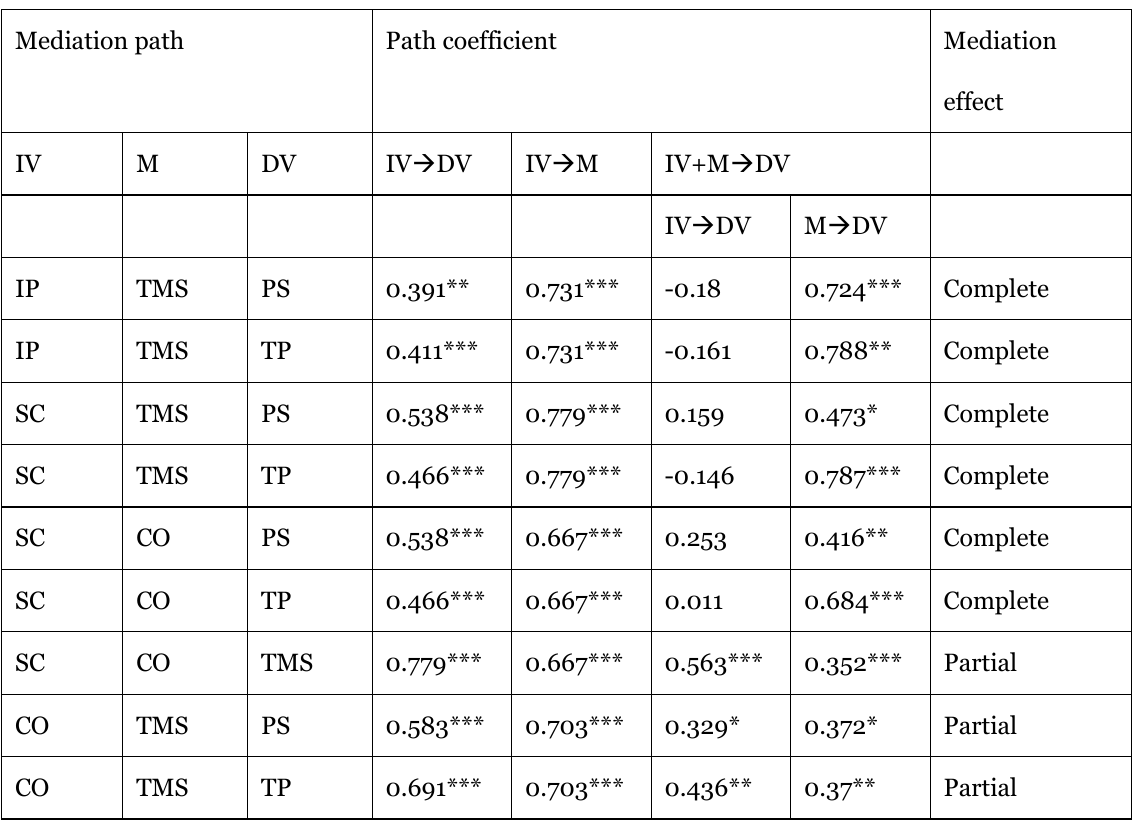
Results of Mediation Analysis Mediation